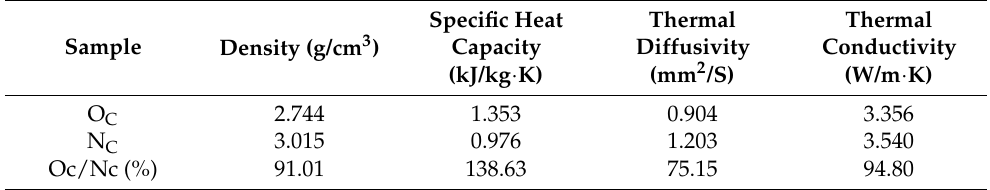
Table 4. Densities, specific heat capacities, thermal diffusivities, and thermal conductivities of the as-sprayed